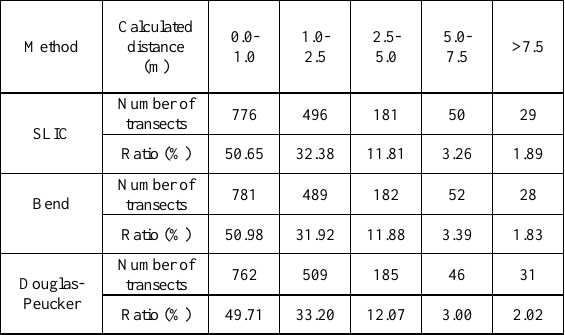
Table 3. Accuracy assessment results.